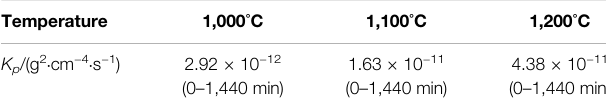
TABLE 2 | Approximate parabolic rate constants of Co-20Re-25Cr-3Si alloys under 0.1 MPa laboratory air at 1,000 – 1,200 ° C for 24 h (g 2 · cm − 4 · s − 1 ). Temperature